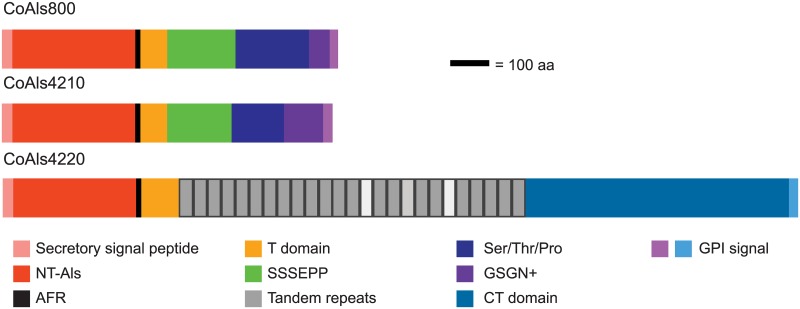
Domain architecture of CoAls proteins.The three CoAls protein sequences were drawn to scale, with domains represented by different colors. Each protein encoded a secretory signal peptide followed by the N-terminal domain (NT-Als) where adhesive function resides in the well-characterized C. albicans orthologs [4, 7]. Each CoAls protein also had a short amyloid forming region (AFR; [8]), and a Thr-rich region (T) domain. Like Als proteins in C. albicans[2], CoAls4220 included a central region of conserved tandemly repeated sequences. Most units were 36 aa, but two (TR14 and TR20) had 34 aa and one (TR17) had 35 aa. CoAls4210 and CoAls800 lacked the central tandem-repeat region. Instead, they had a short, imperfect repeated sequence (SSSEPP consensus), a Ser/Thr/Pro-rich region, and another short, imperfect repeat (GSGN consensus). Each CoAls protein had C-terminal signal for GPI anchor addition, predicting its localization in the fungal cell wall [3].